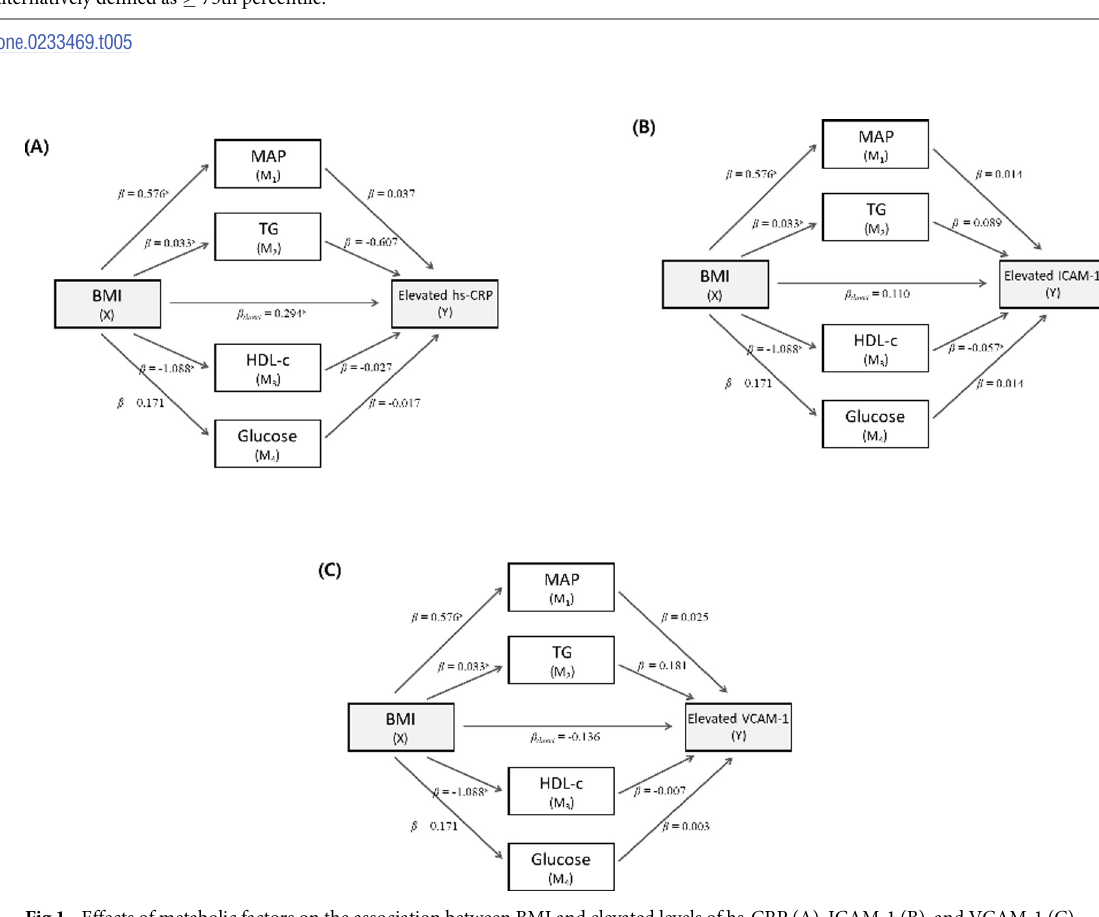
Fig 1. Effects of metabolic factors on the association between BMI and elevated levels of hs-CRP (A), ICAM-1 (B), and VCAM-1